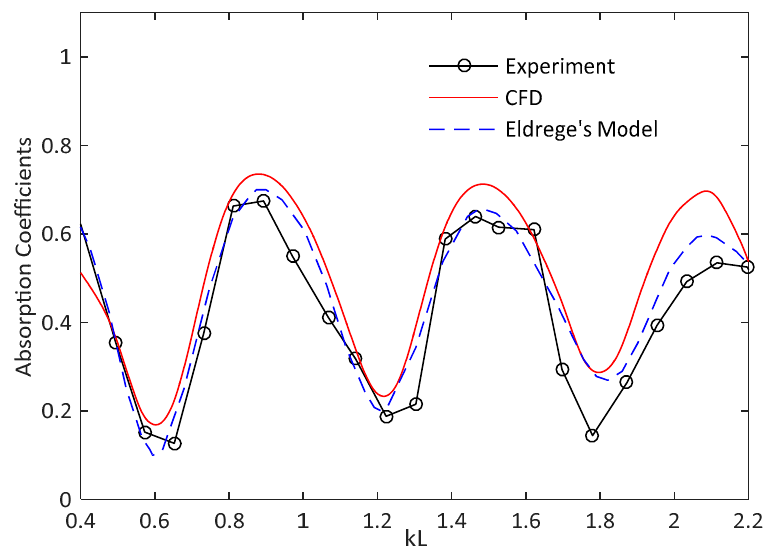
Figure 8. Numerical and experimental comparison of absorption coefficients at M in = 0.041 and zero grazing flow conditions [21].